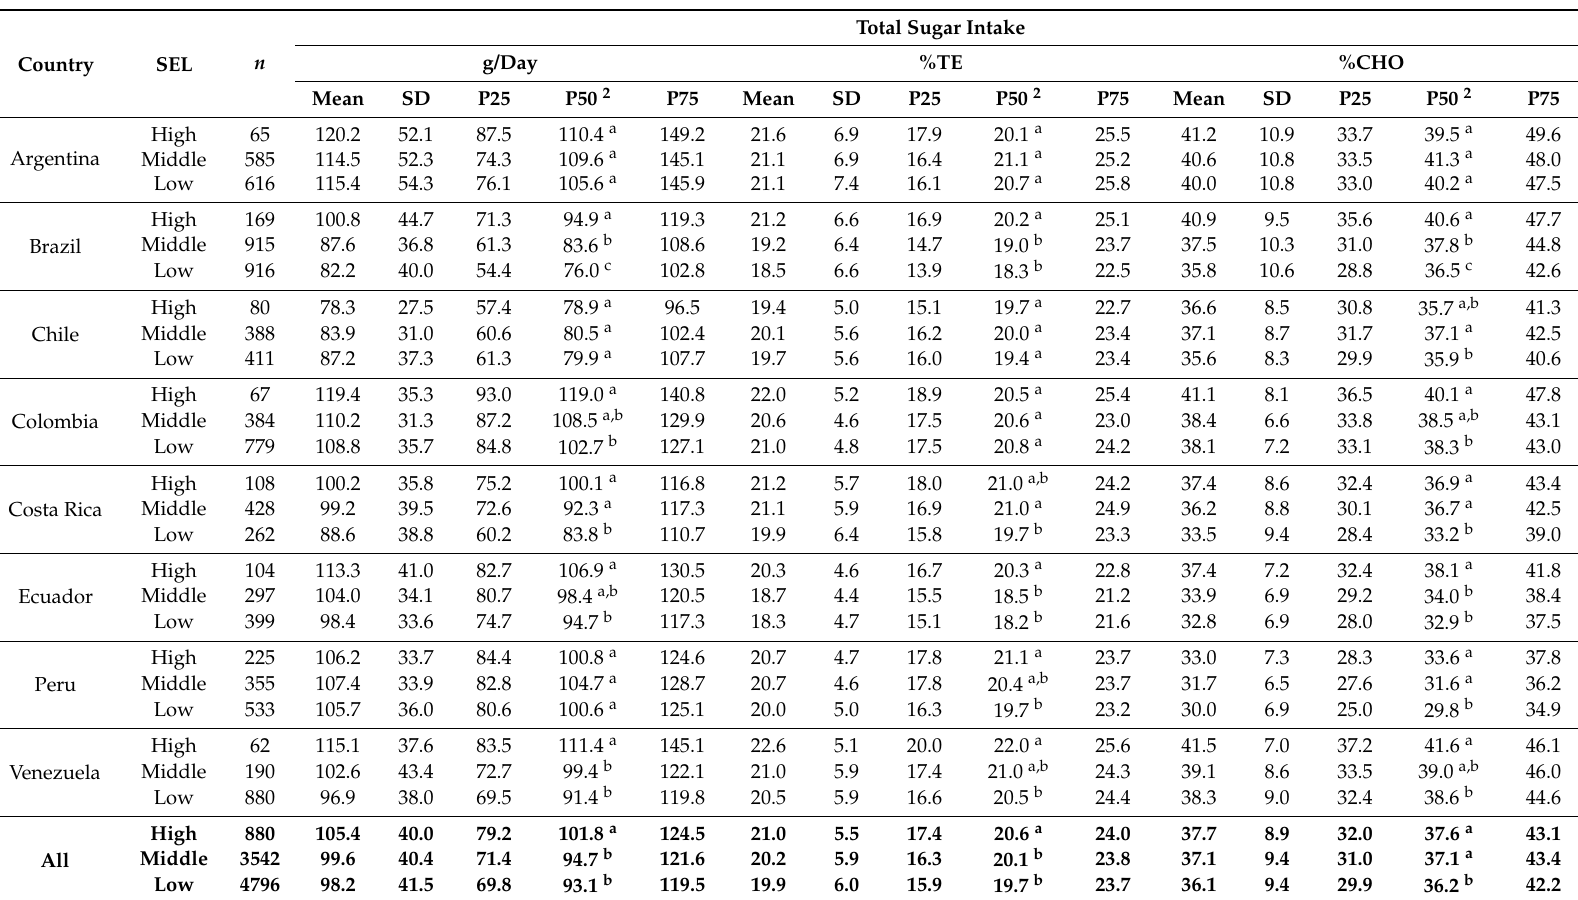
Table 5. Total sugar intakes 1 in individuals residing in urban areas of Latin American countries, according to socioeconomic level; Latin American Health and Nutrition Study (ELANS),